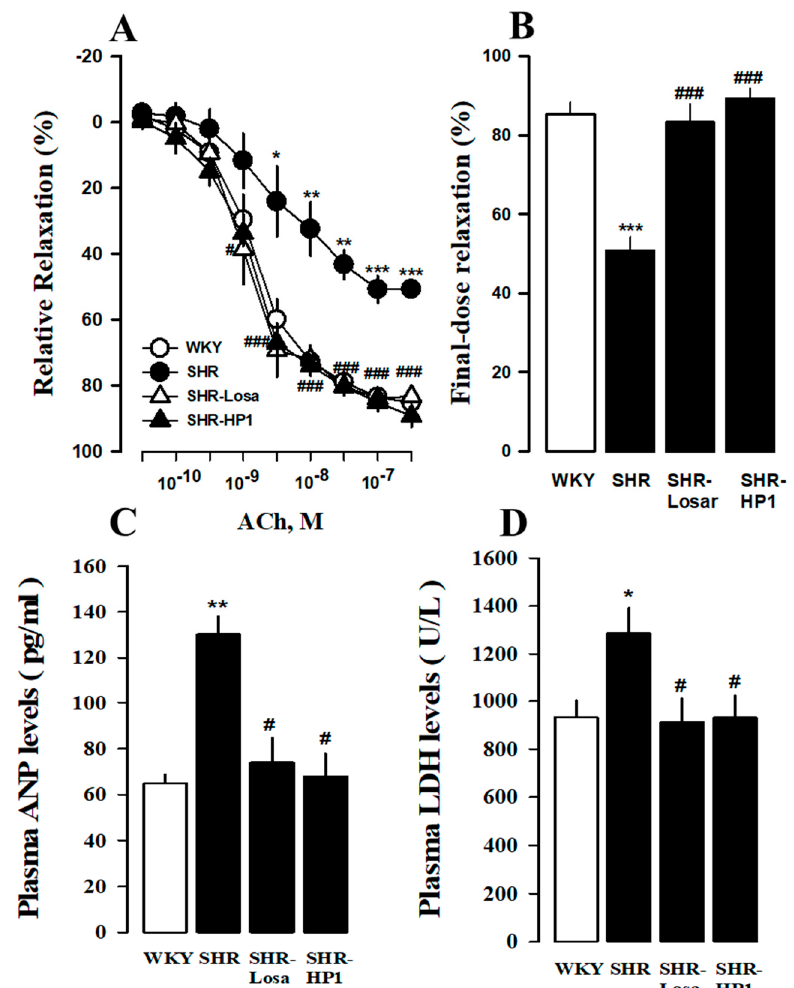
Figure 5. E ff ects of HP1 on isolated rings of thoracic aorta and hematological change in SHRs. Vascular relaxation by acetylcholine (Ach, A ) and relaxation by acetylcholine final dose ( B ) in thoracic aortic rings. The levels of plasma atrial natriuretic peptide (ANP, C ) and lactate dehydrogenase (LDH, D ) of HP-1-treated in SHRs. WKY, Wistar-Kyoto rat; SHR, spontaneously hypertensive rat; Losa, losartan; and HP1, Vitis labrusca leaves extract. Open bar, WKY; closed bar, SHRs. The values represent the means ± standard error ( n = 5 for each group). * p < 0.05, ** p < 0.01, *** p < 0.001 vs. WKY; # p < 0.05, and ### p < 0.001 vs. SHRs.